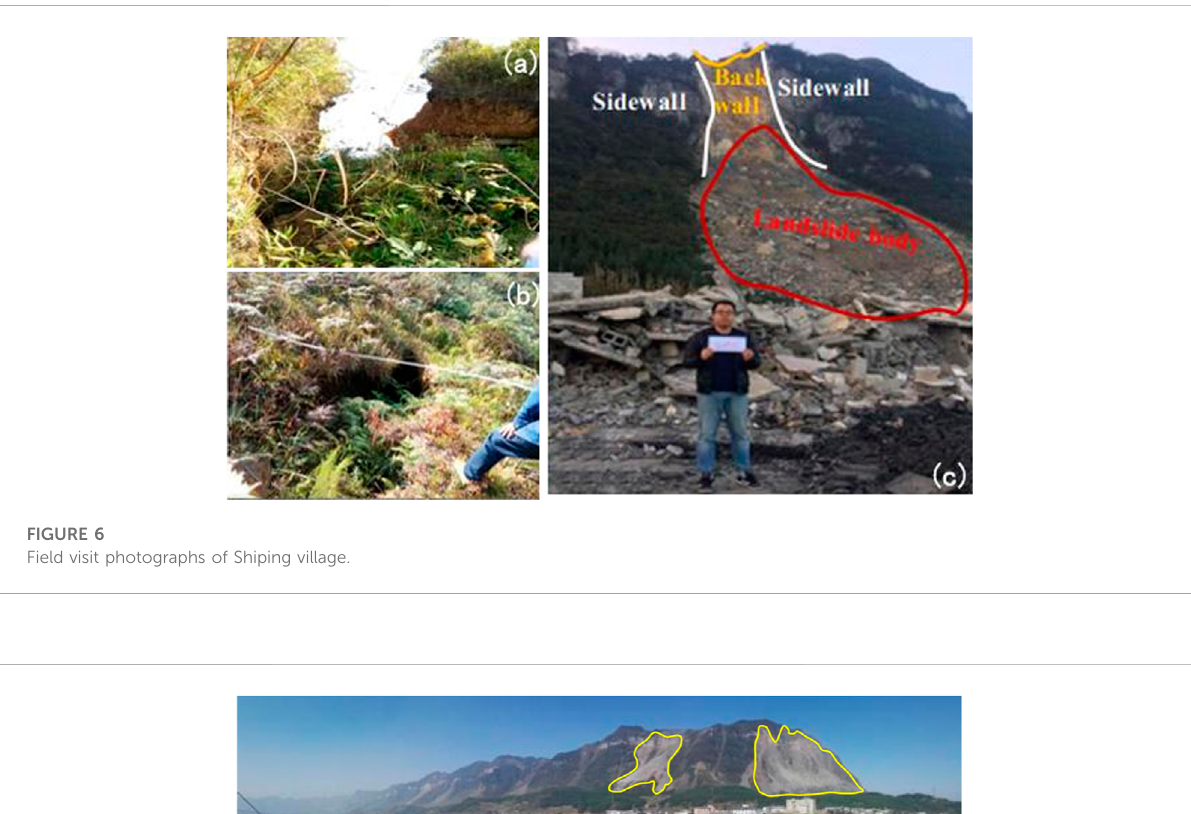
FIGURE 7 Panoramic view of Zongling and nearby